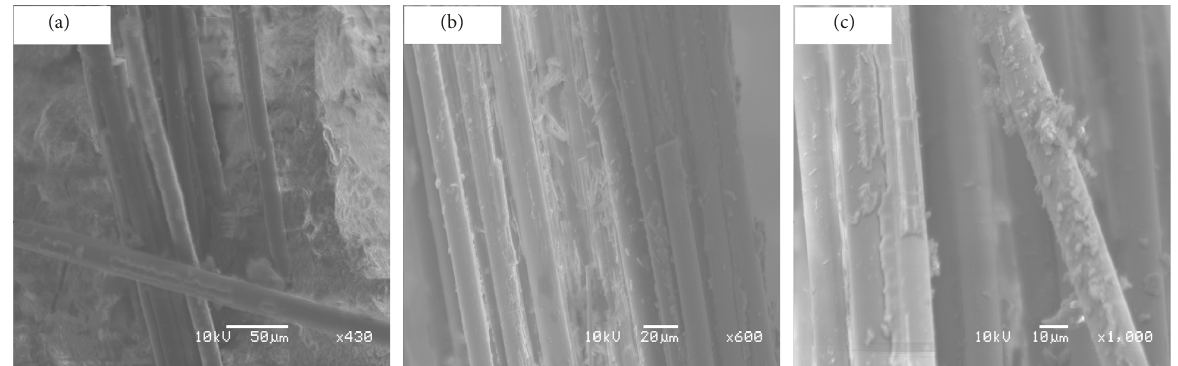
Figure 4: Microstructure of the fibre surface in CSA/GFRC cured for 7d at (a) 50 ° C, (b) 70 ° C, and (c) 80 °